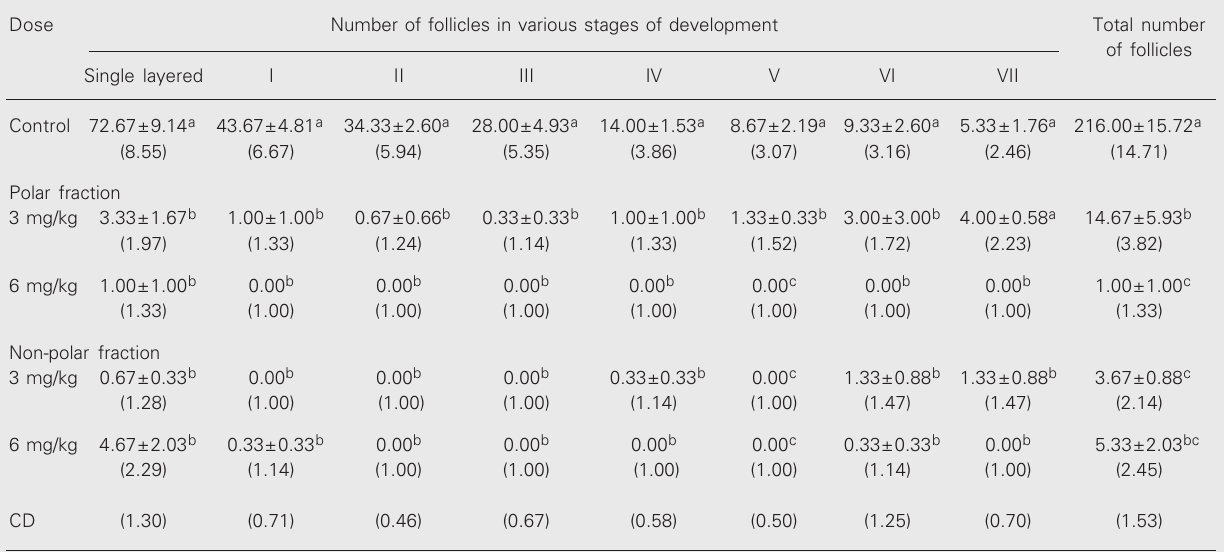
Table 1. Number of normal follicles in various stages of follicular development in the ovaries of albino rats treated orally with polar fraction and non-polar fraction of Azadirachta indica (neem) seed